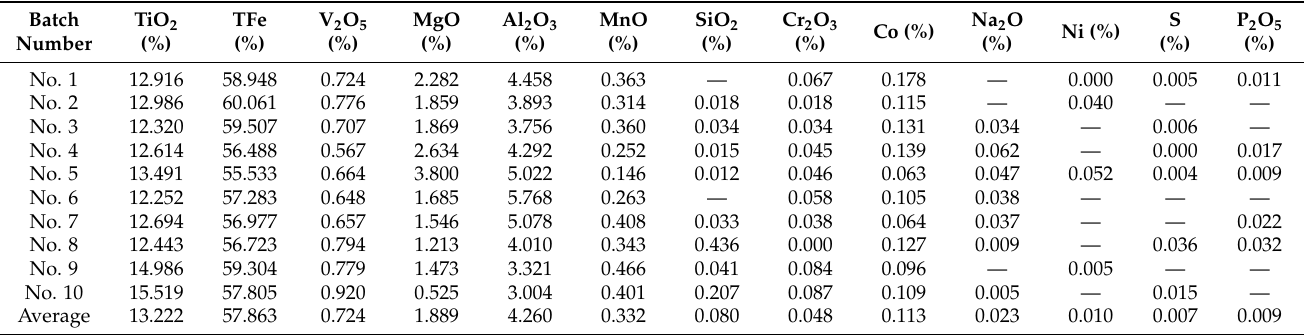
Table 6. Chemical composition of titanomagnetite in the different ore